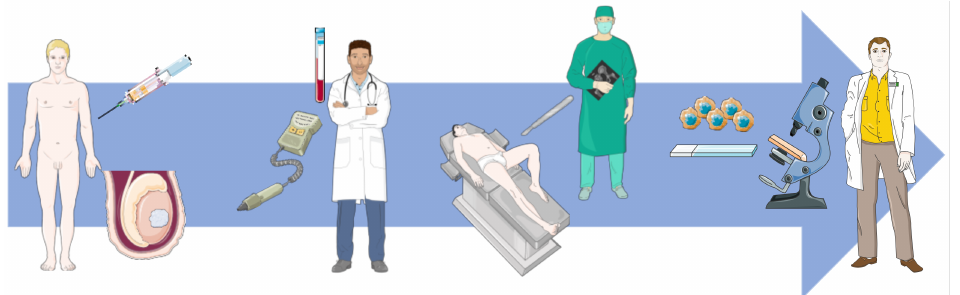
Figure 1. Clinical path of a patient with a testicular mass. Clinical work-up includes physical examination, scrotal ultrasound and classical serum tumor markers (AFP, HCG, and LDH) evaluation. The patient is ultimately submitted to removal of the testis (orchiectomy) and the definitive diagnosis (which can be a germ cell tumor, another tumor or even a benign inflammatory condition) is only provided by histopathological examination of the